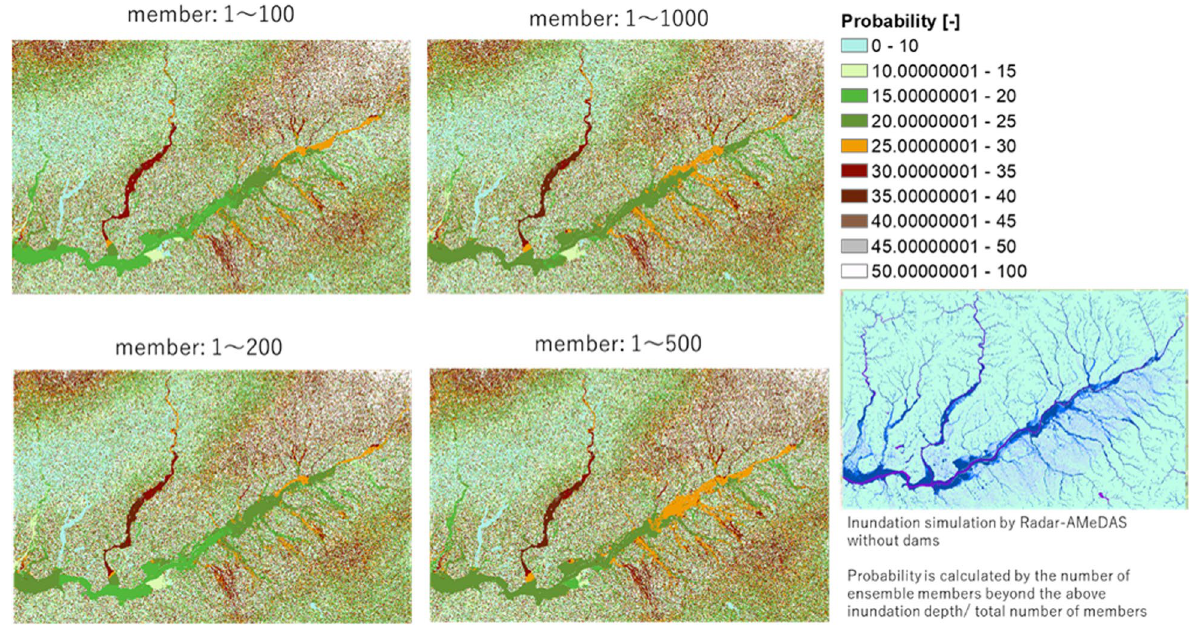
Fig. 16 The probabilities (%) of selected ensemble members beyond the inundation depth simulated by